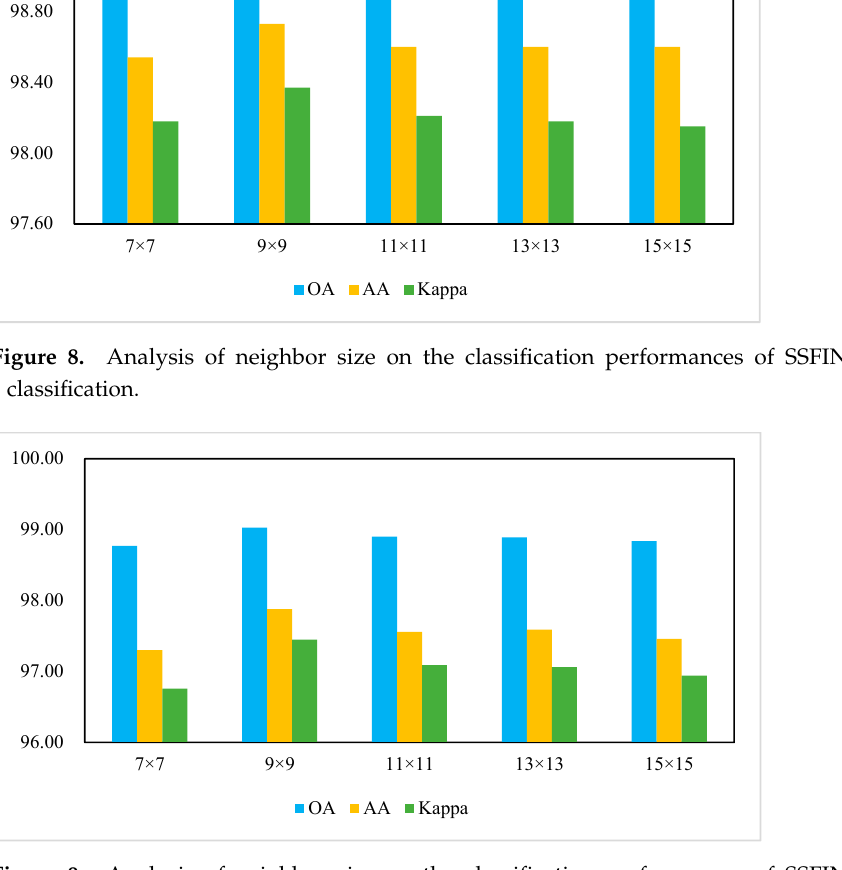
Figure 9. Analysis of neighbor size on the classification performances of SSFIN for dataset 2 classi- fication.